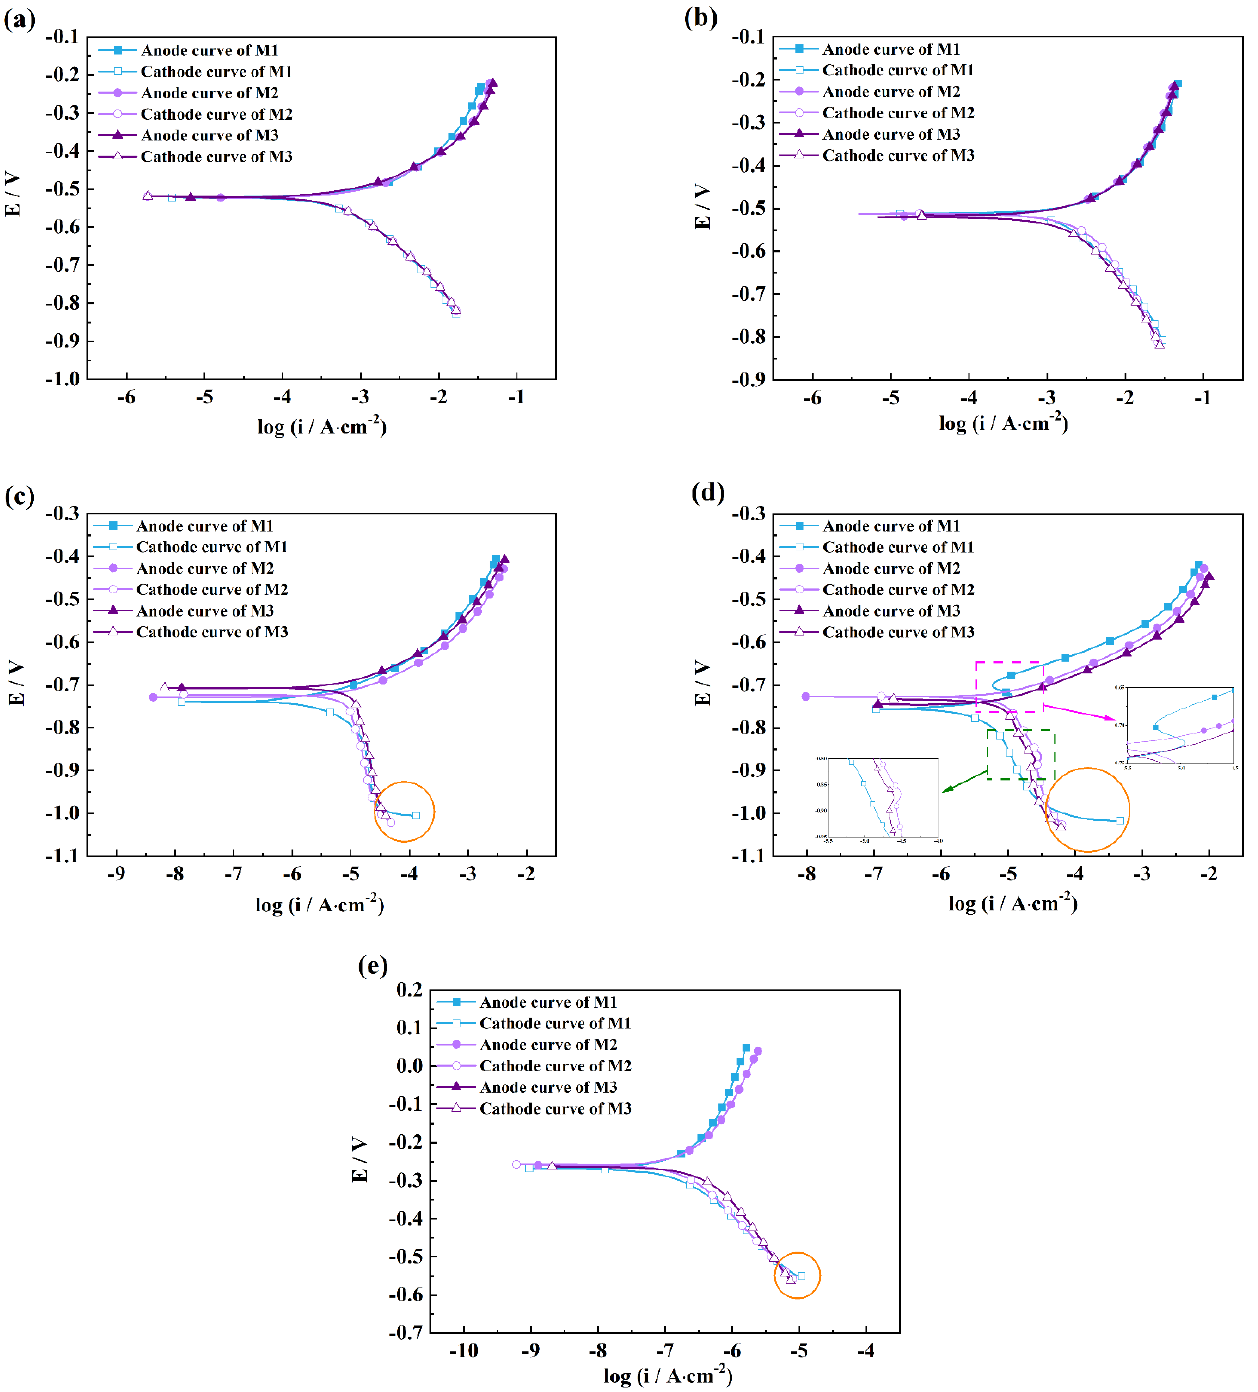
Figure 2. Comparison of the strong-polarization curves measured by three measuring methods in five solutions of HCl ( a ), H 2 SO 4 ( b ), NaCl ( c ), Na 2 SO 4 ( d ), and NaOH ( e ). (Skip points were 80 for clarity.) Table 1. Maximum anodic and cathodic current densities of Tafel curves using three methods in five solutions.